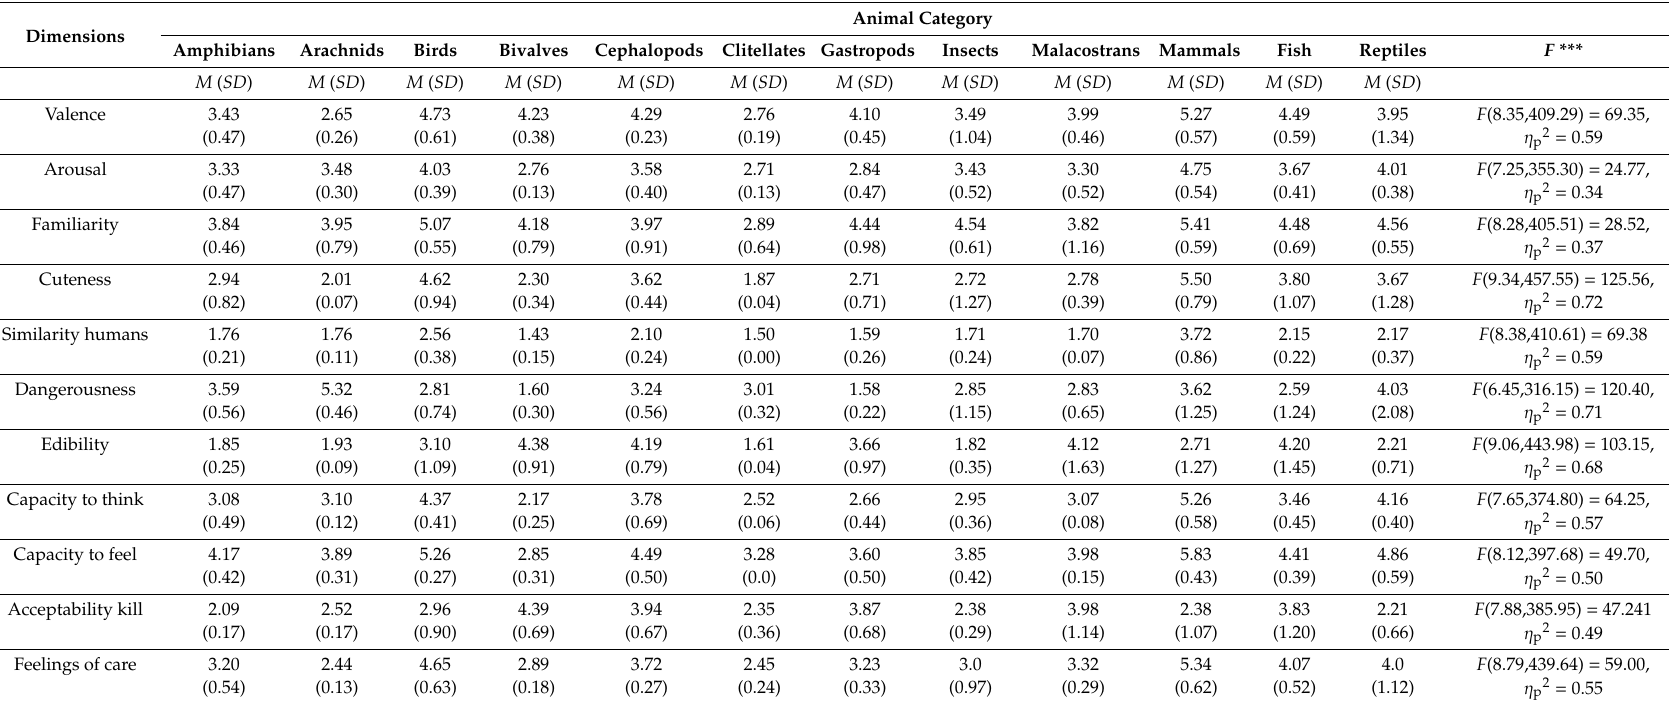
Table 7. Means and standard deviations for each evaluative dimension by animal